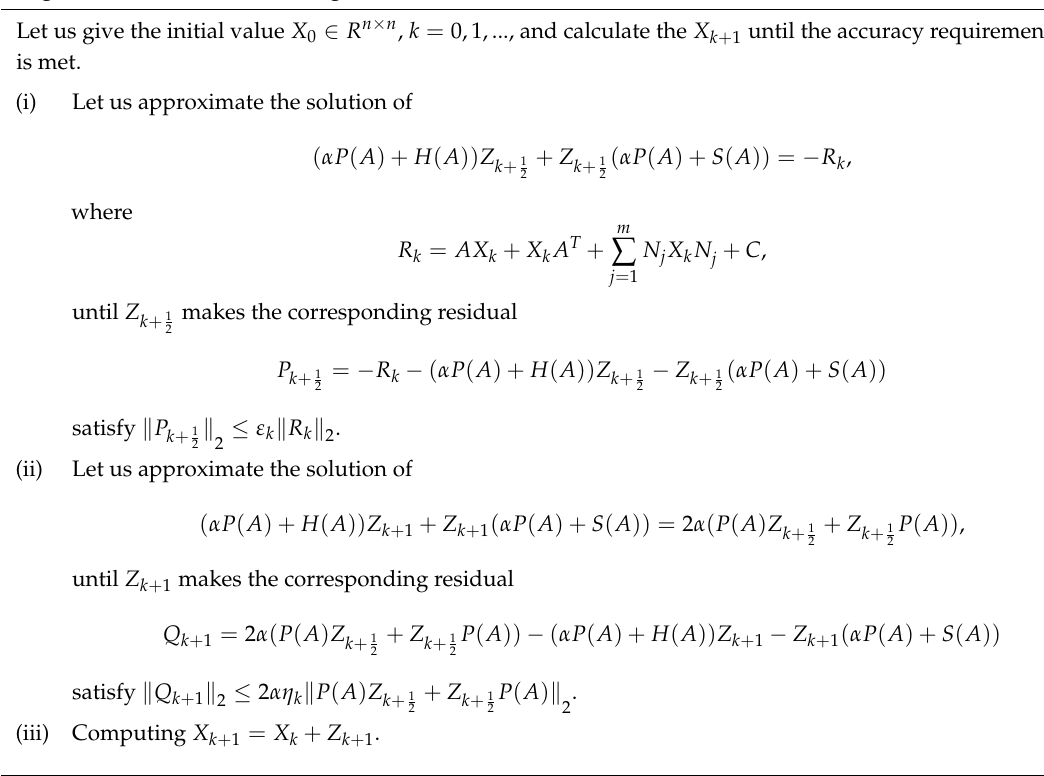
Algorithm 1. (Inexact PHSS